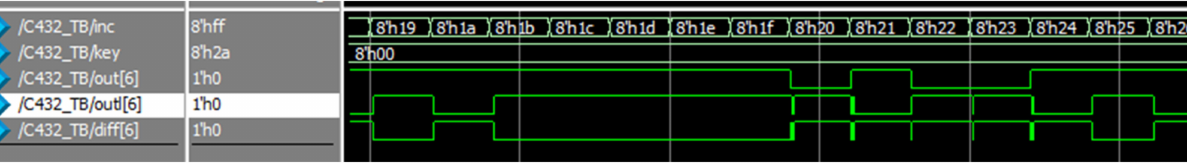
Figure 21. Output signals of the original and locked netlists for the incorrect